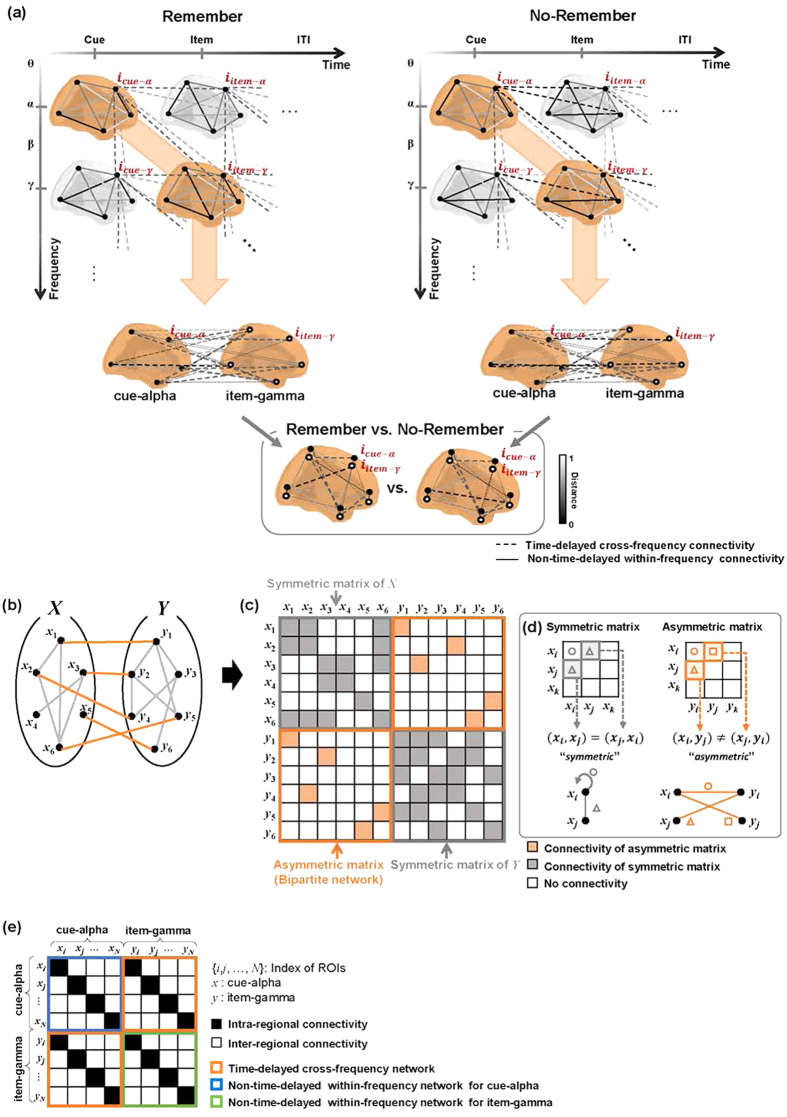
Illustration of analysis of the present study.(a) Among many coupling possibilities, we focused on interactions between cue-alpha (alpha power during cue presentation) and item-gamma (gamma power during item presentation) (orange brains). This time-delayed cross-frequency negative coupling was finally compared between conditions (Remember vs. No-Remember). Networks derived from within-frequency cross-time or within-time cross-frequency coupling were simply not chosen for further analysis. (b) The selected network of (a) is modeled by a bipartite graph, which consists of two disjoint sets of nodes and edges linking the nodes. Assume there are two sets of nodes,  and , and their relationship (edges; orange lines) when X and Y indicates different properties of the same sources ({i, …, N}). To address its characteristics, we additionally illustrated the typical type of a network with single set of nodes and edges (gray lines). (c) Once a graph is transformed into a matrix form for analysis and display, there is an asymmetric matrix (orange box) for bipartite graph, while a symmetric matrix (gray box) for each X and Y network, respectively. Note that two asymmetric matrices are the same when transpose either of the two. (d) The asymmetric matrix is produced due to the fact that each row and column of the matrix is aligned by different properties (X and Y) while nodal index is the same. For the typical network, two edges at (i, j) and at (j, i) link the same index and property of nodes , yielding a symmetric matrix. However in the bipartite graph, they links the same index but different property of nodes: , leading to an asymmetric matrix. (e) In the present study, each set of nodes (X and Y) indicates cue-alpha and item-gamma and nodal indices (i, …, N) are ROI labels. The bipartite network (orange box) represents time-delayed cross-frequency network including edges within the single region (intra-regional connectivity; black) and between different regions (inter-regional connectivity; white). The properties of time-delayed cross-frequency network are examined by being compared to two non-time-delayed within-frequency networks (for cue-alpha: blue; for item-gamma: green).